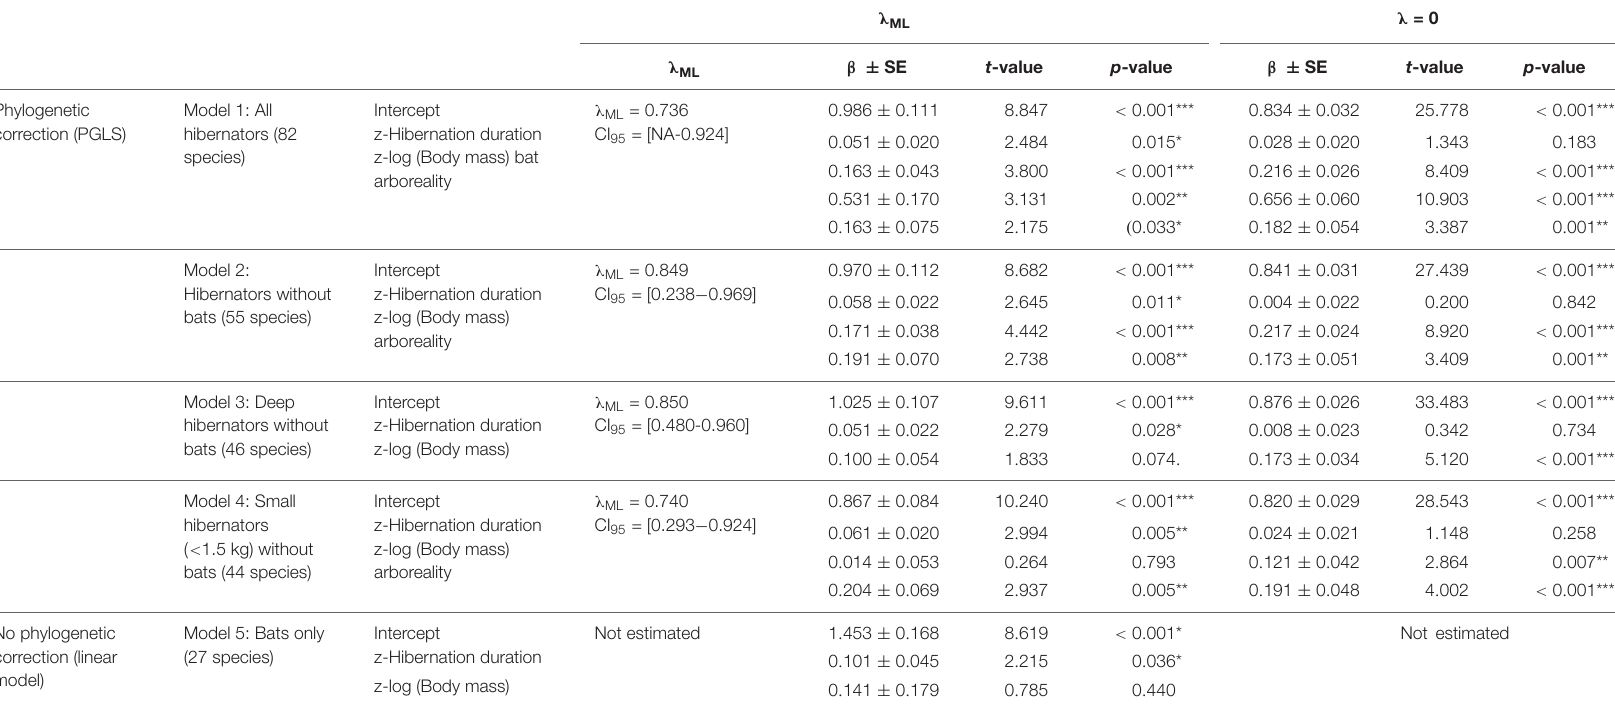
TABLE 2 | Regression results for the best models explaining variation in longevity among hibernators